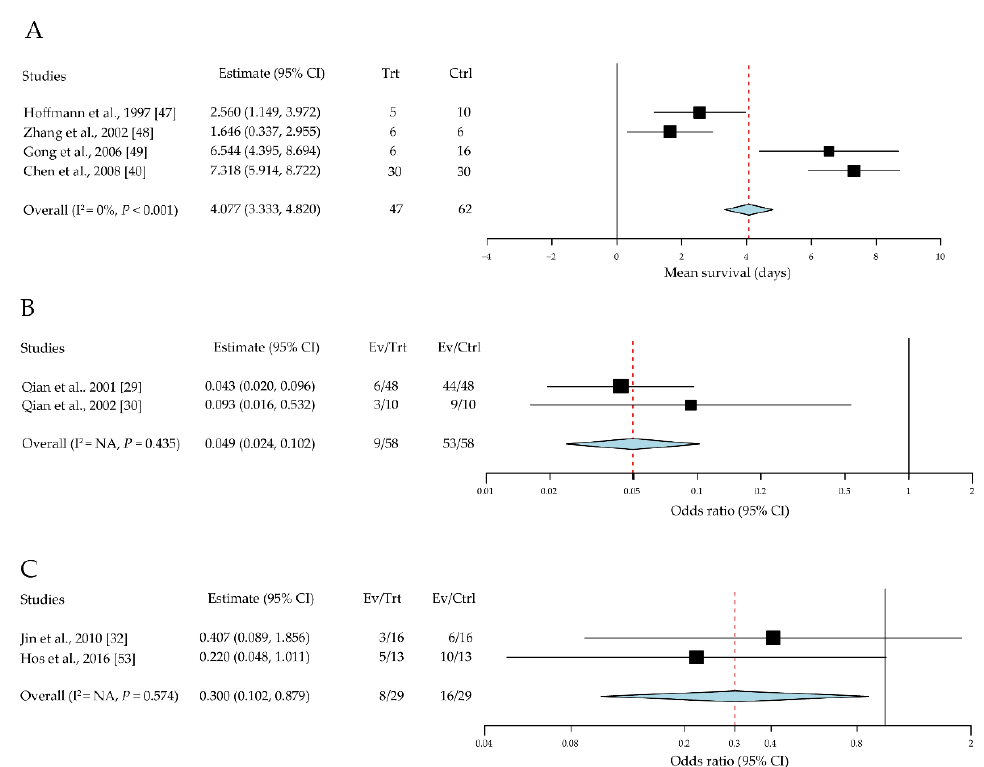
Figure 4. Blockage of co-stimulatory pathways influences corneal-allograft survival. ( A ) CLTA-4 Ig promotes allograft survival. ( B ) Anti-CD154 antibody increases the allograft survival rate. ( C ) CCR7-CCL19 blockade improves the allograft survival rate. CI, confidence intervals; EV, event; Trt, treatment; Ctrl, control.